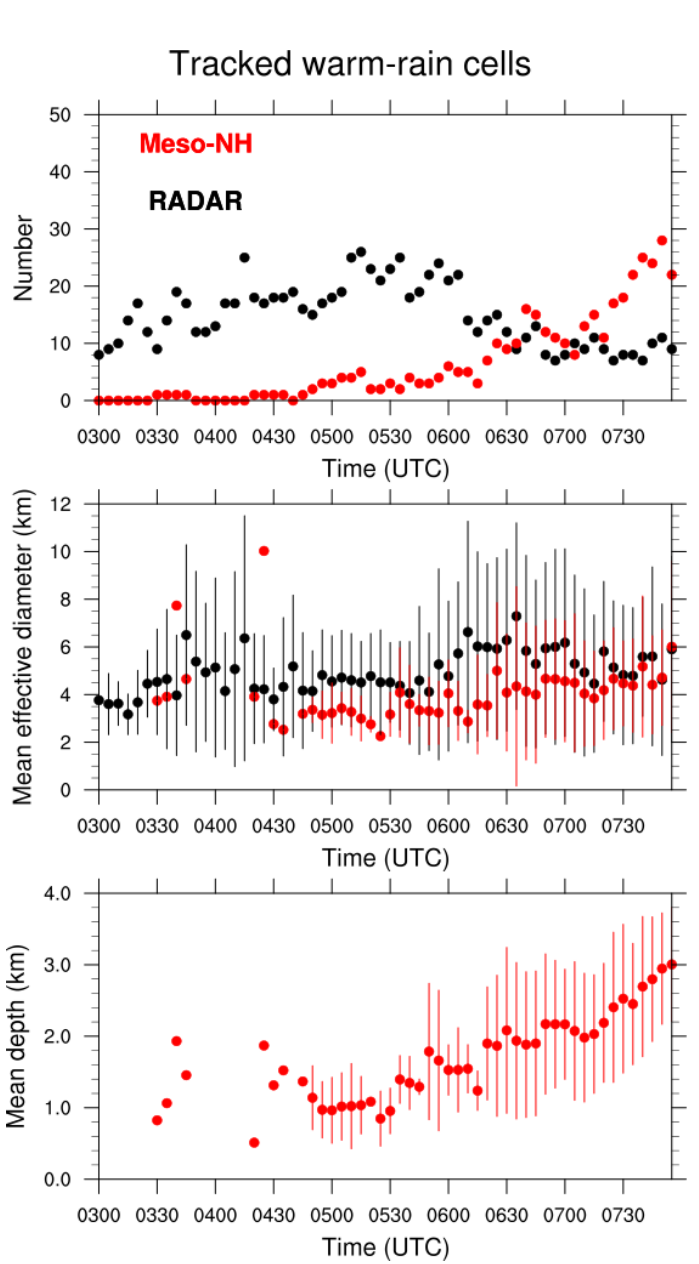
Figure 8. Time series of the number, effective diameter and depth (only for the simulation) of the tracked warm-rain cells, corresponding to those represented in Figures 9 and 10. The dots show the mean value and the error bars represent the standard deviation for the effective diameter and